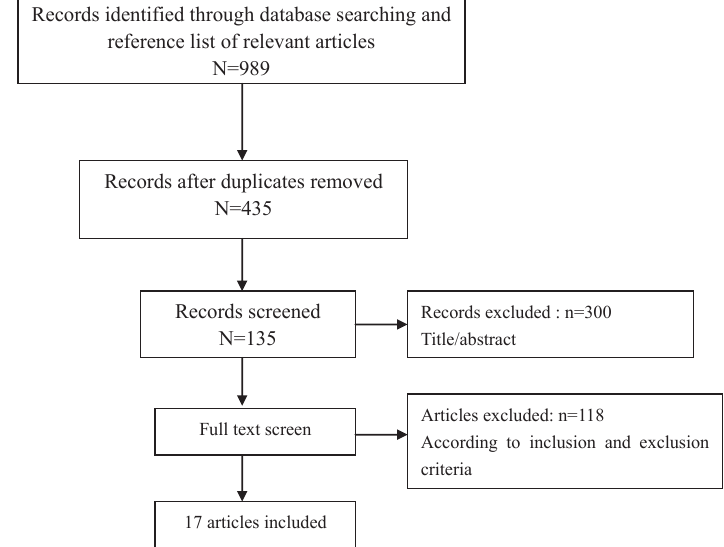
Figure 1 - Selective process using preferred reporting items for systematic reviews and meta-analyses (PRISMA)